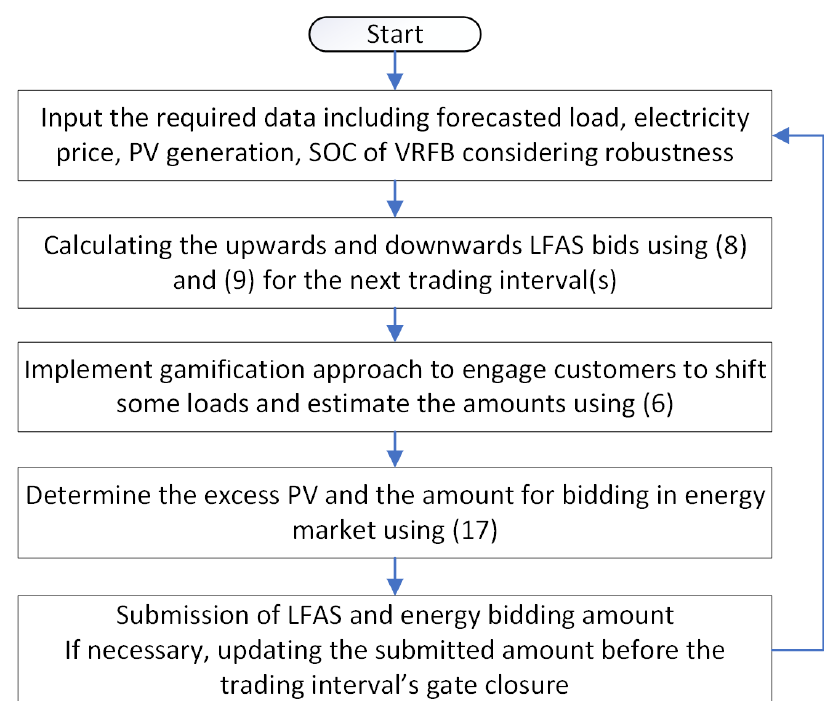
Figure 2. The flowchart for the bidding strategy in the LFAS and energy